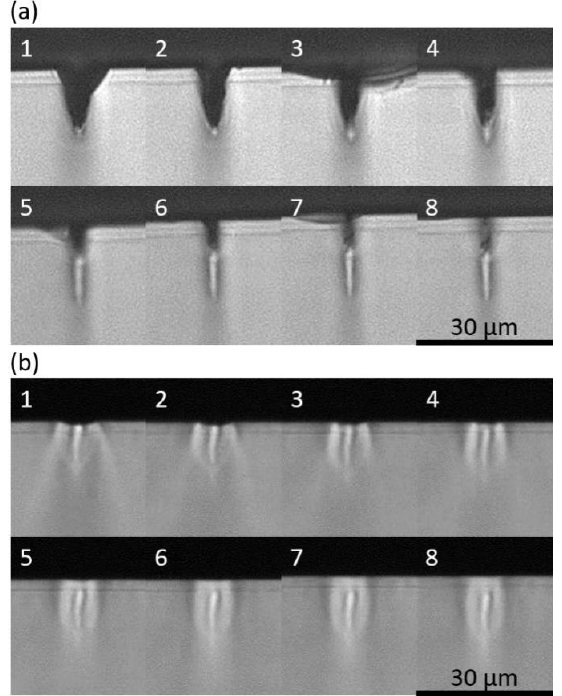
Fig. 1. Cross-section of waveguides fabricated in Suprasil 1 (a) and Eagle 2000 (b) at a depth of 50 + 0.5 × 𝑛 µm (n=waveguide number) after being etched to the surface in HF 10%.